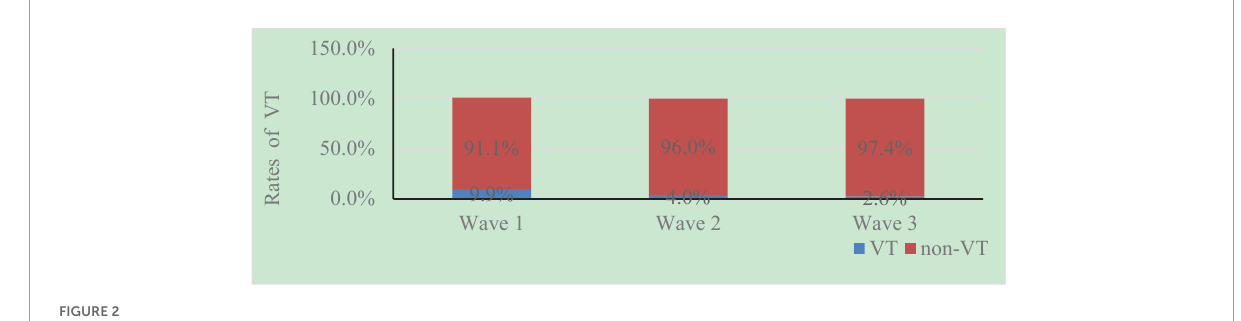
FIGURE2 The rates of VT at different time points in college students.